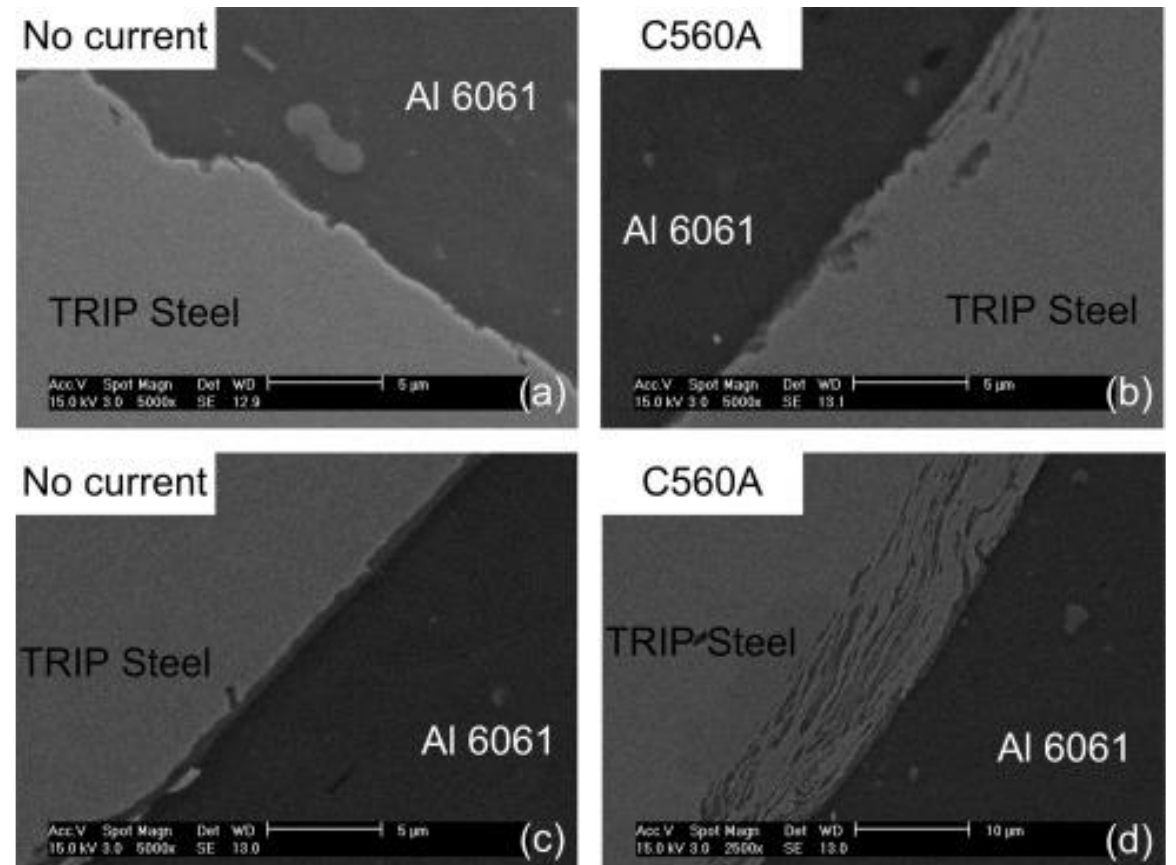
Figure 5. IMC thickness at interface of aluminum alloy and steel in ( a ) upper area and ( b ) lower area of FSW joint. Reprinted with permission from ref. [48]. Copyright 2022 Elsevier. IMC thickness at interface of aluminum alloy and steel in ( c ) upper area and ( d ) lower area of EA-FSW joint. Reprinted with permission from ref. [48]. Copyright 2022 Elsevier.